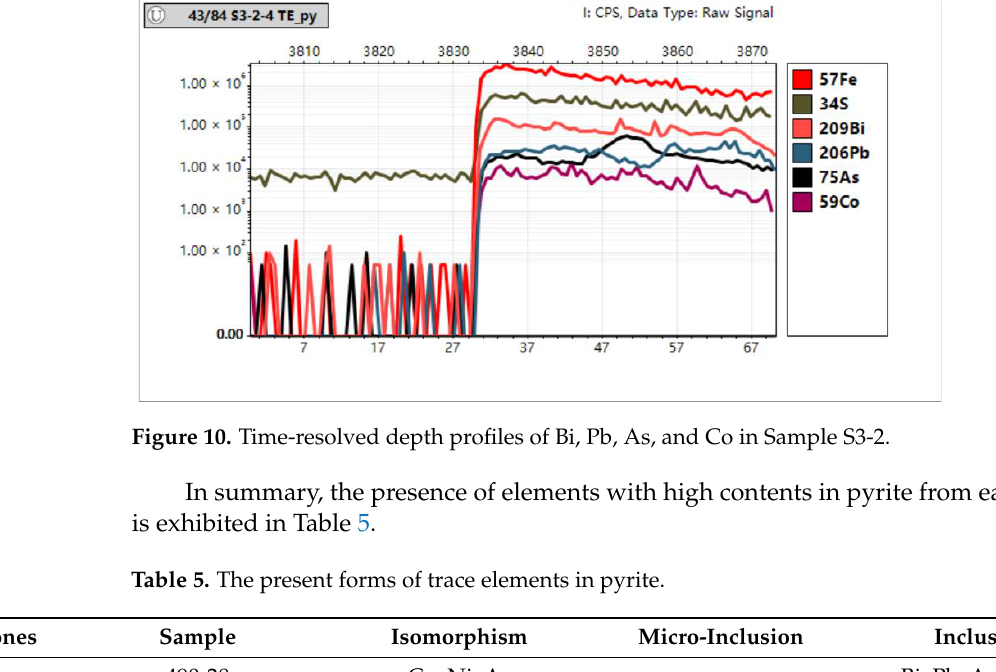
Figure 9. Time-resolved depth profiles of Co, Pb, Ni, As, Sb, and Tl in Sample 490-13.